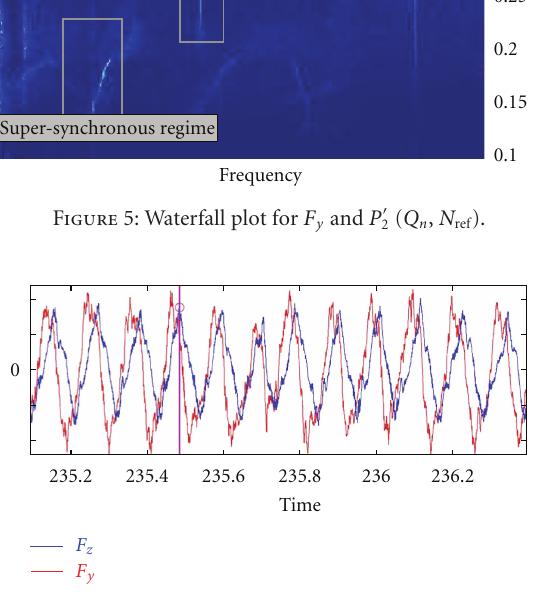
Figure 6: Time signals of F y and F z during the super-synchronous regime ( Q n , N ref , cut-o ff frequency 400 Hz).